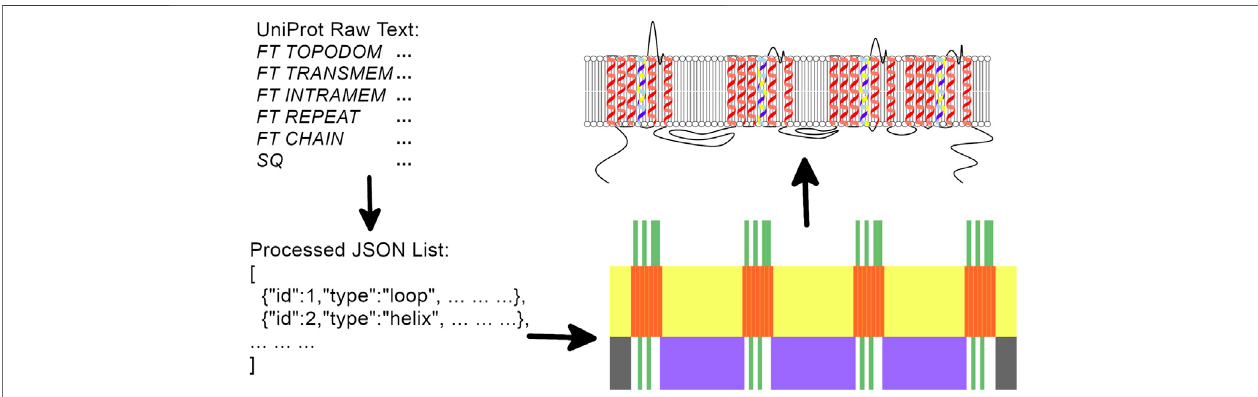
FIGURE1| Naview ’ sgeneralwork fl ow:UniProt formatteddataisinitially checked and processed beforeinitialdraw areas arepre-calculated from the Style Object width, height and border de fi nitions. These areas de fi ne the positioning of each drawn element in the following order: Membrane, Helices, Short Loops, Pore Loops, Long Loops, N and C terminal Loops. As each protein element is rendered, anchorage points are de fi ned for proper loop positioning. Properties de fi ned from the Style Obj or mapped from user selected settings de fi ne colors and drawing modes for each of the drawn features.